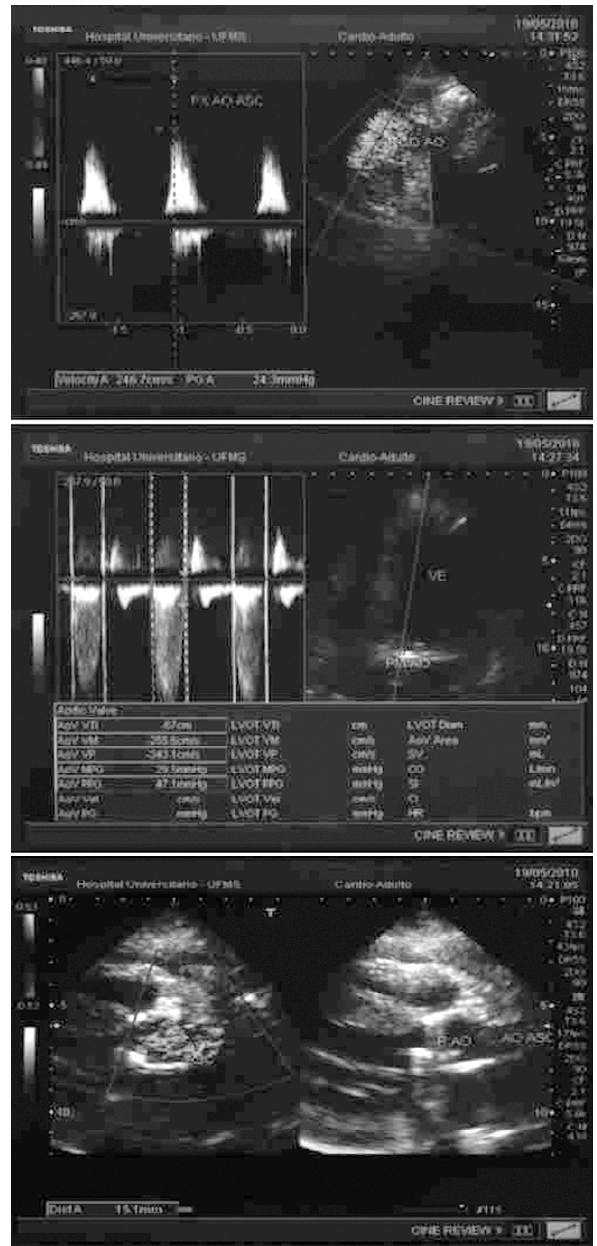
Fig. 3 – Ecocardiograma